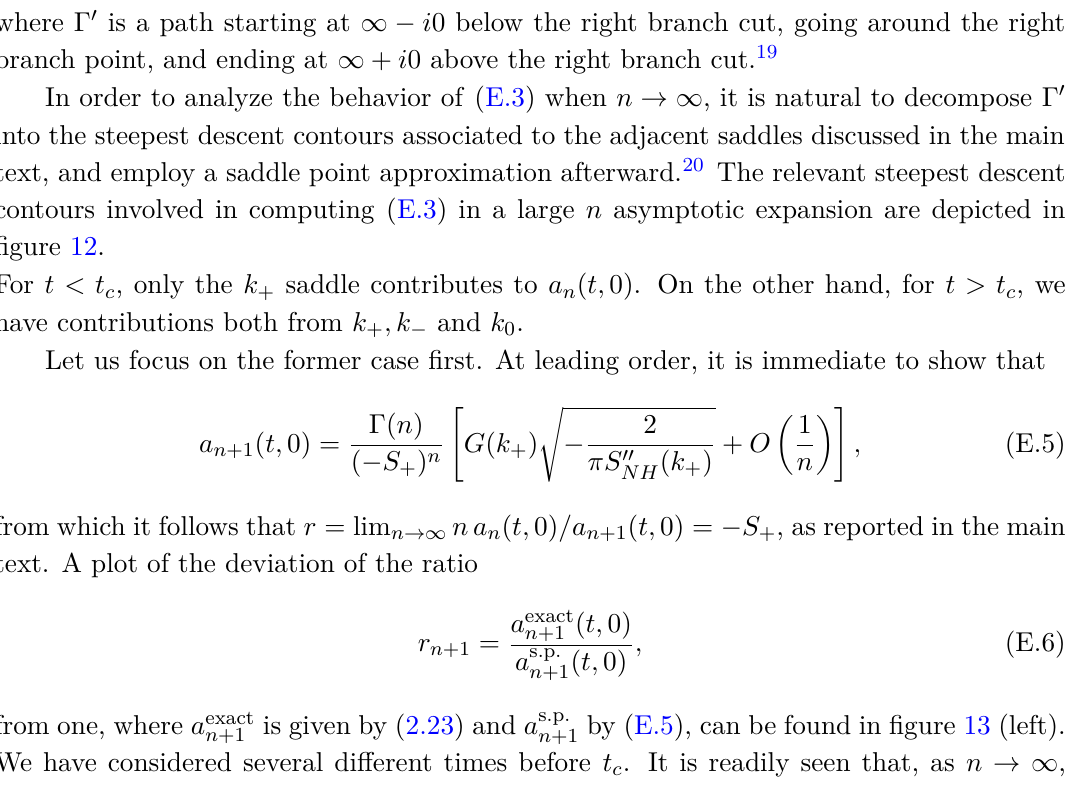
where Γ 0 is a path starting at ∞ − i 0 below the right branch cut, going around the right branch point, and ending at ∞ + i 0 above the right branch cut.